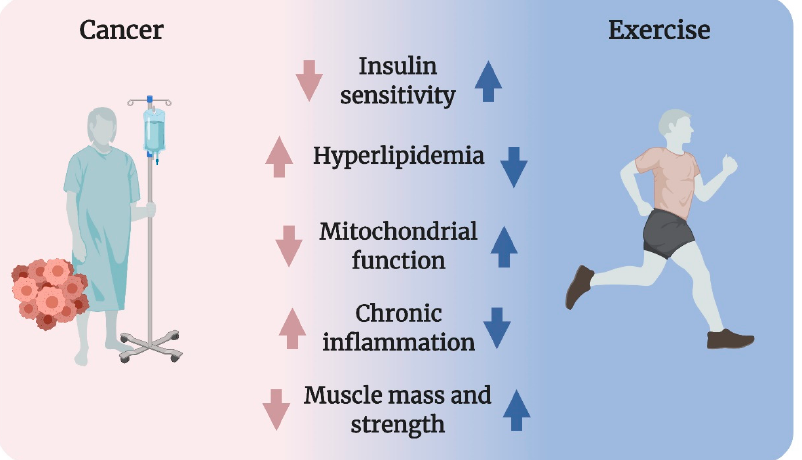
Figure 1. Cancer is often associated with reduced insulin sensitivity, hyperlipidemia, impaired mitochondrial function, chronic inflammation, as well as lowered muscle mass and strength (cancer cachexia). Exercise powerfully improves all of these conditions in healthy humans, suggesting that exercise could be a strategy to counter metabolic derangements in